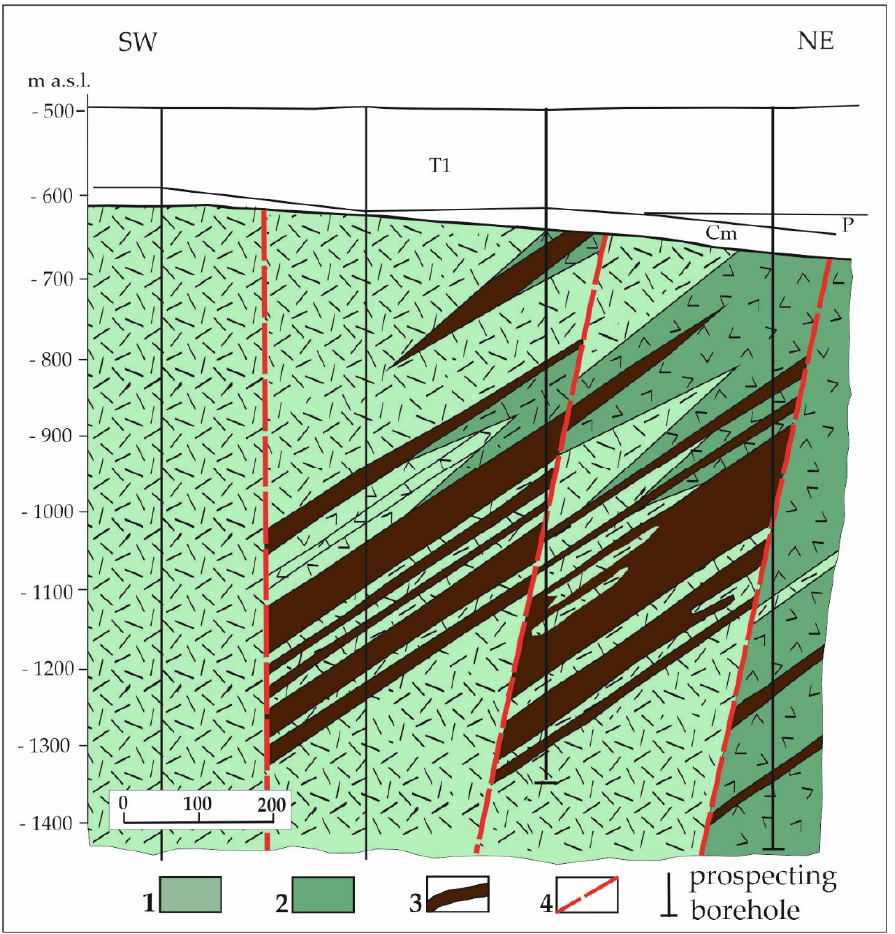
Figure 3. Geological cross section (without Cenozoic sedimentary rock cover) of the Udryn Fe-Ti-V ore deposit (modified after [39]). Abbreviations: 1—anorthosite; 2—norite; 3—ilmenite-magnetite ore; 4—fault. T1—Lower Triassic; P—Permian; Cm—Cambrian.